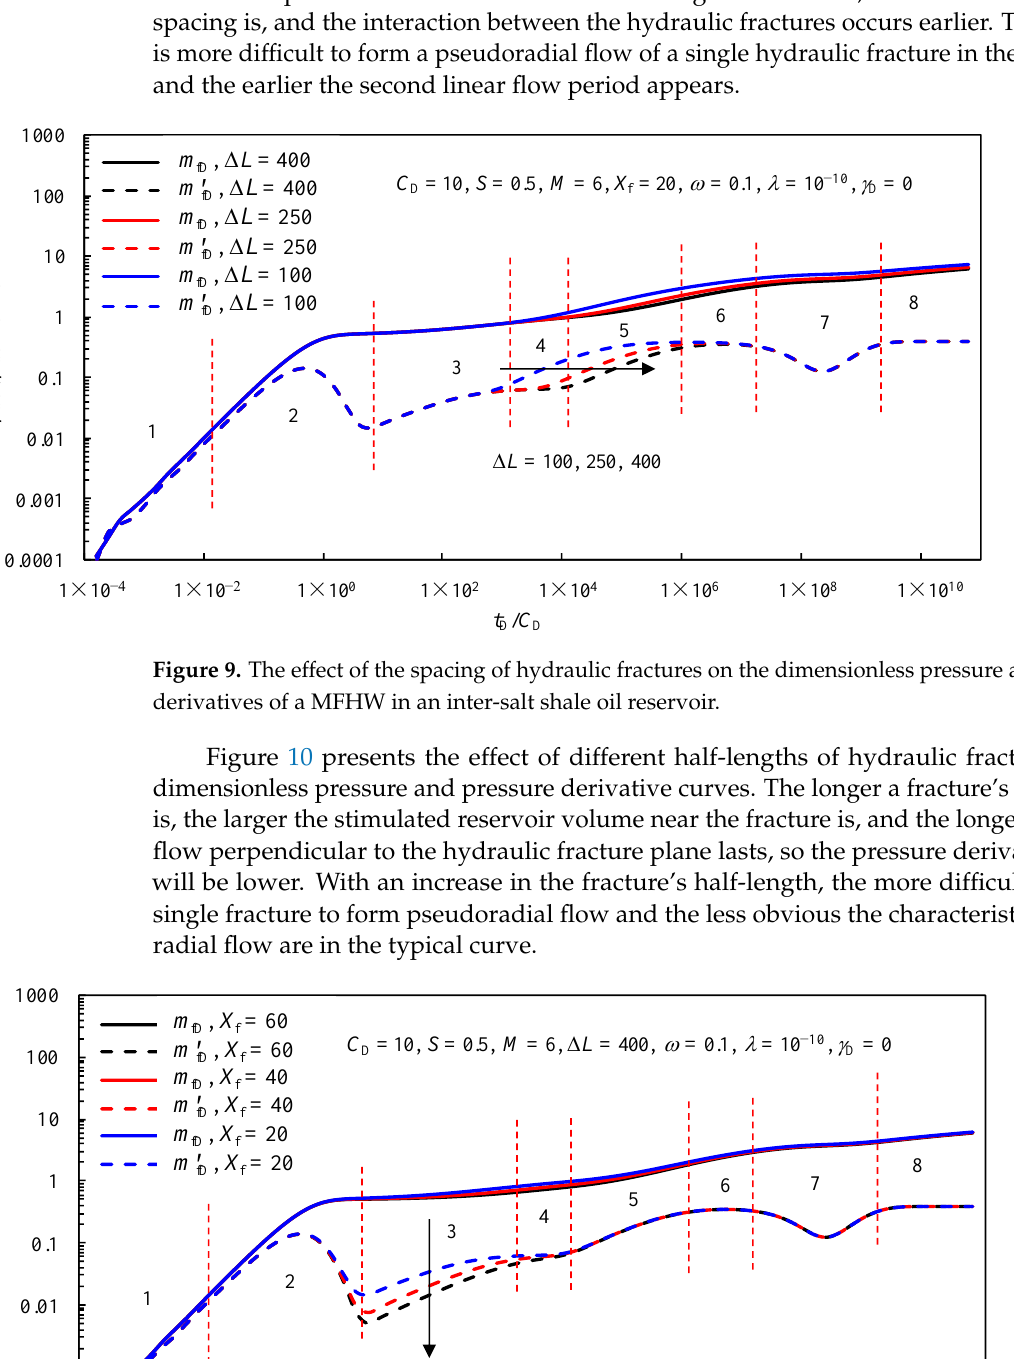
Figure 8. The effect of the number of transverse fractures on the dimensionless pressure and pres- sure derivatives of a MFHW in an inter-salt shale oil reservoir.